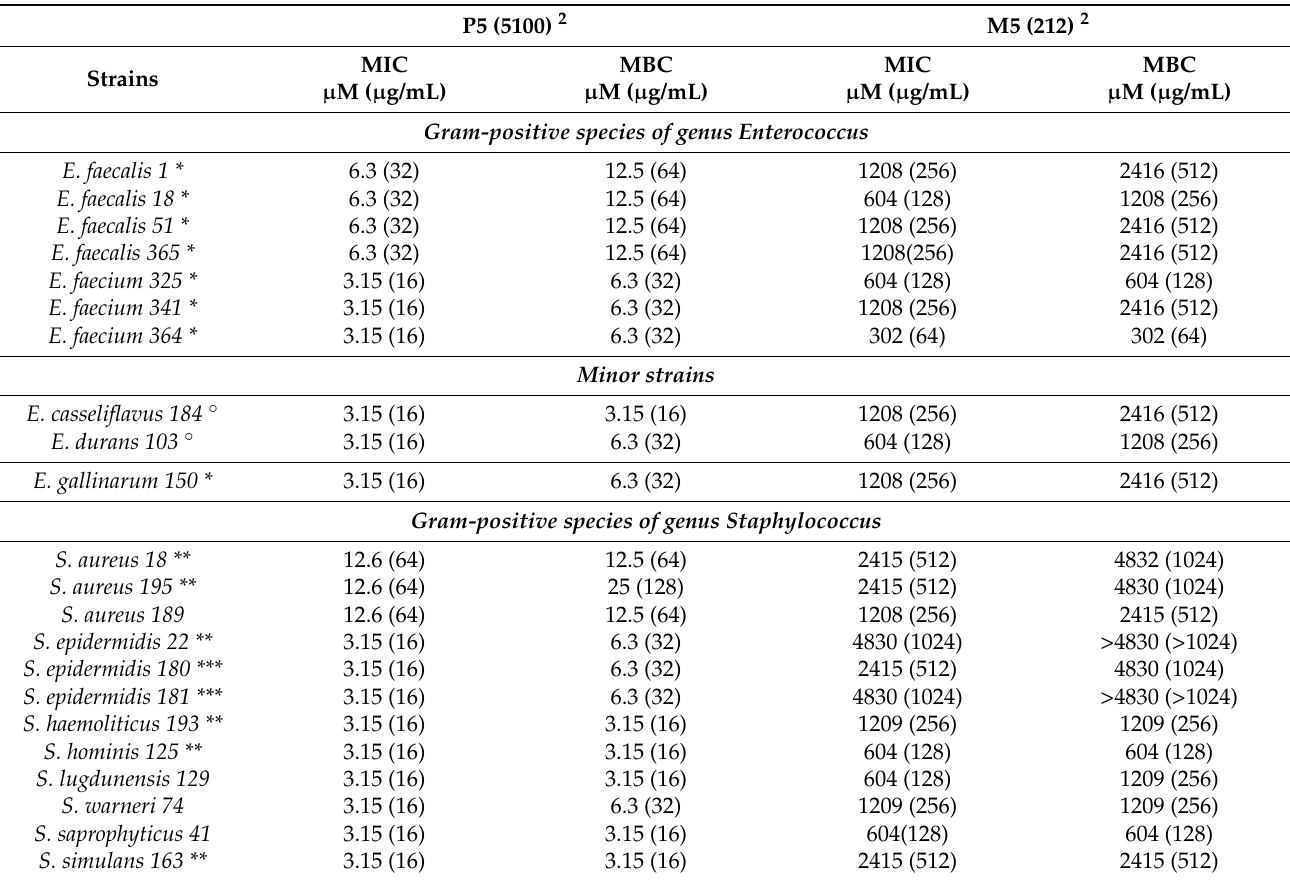
Table 4. MIC and MBC values of P5 and of the monomer M5, obtained from experiments carried out in triplicate 1 , expressed as µ M and as µ